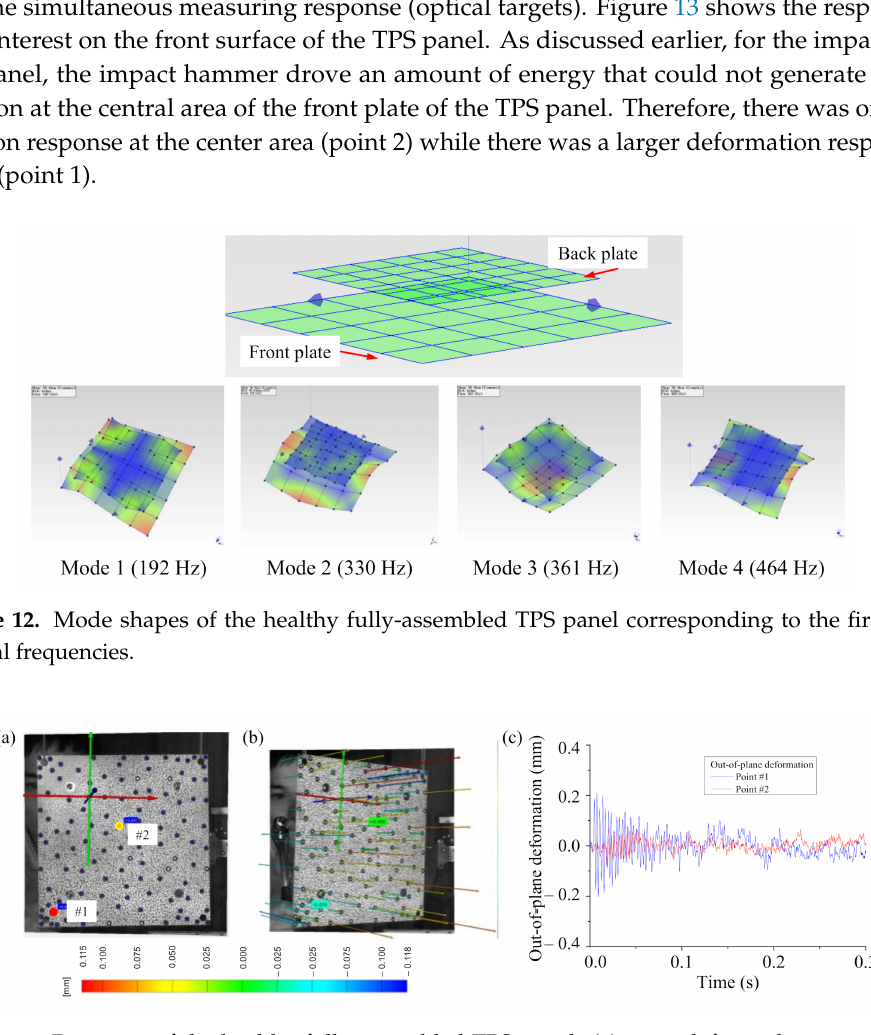
Figure 13. Response of the healthy fully-assembled TPS panel: ( a ) an undeformed state and ( b ) a deformed state with the points of interest, ( c ) response history of the points of